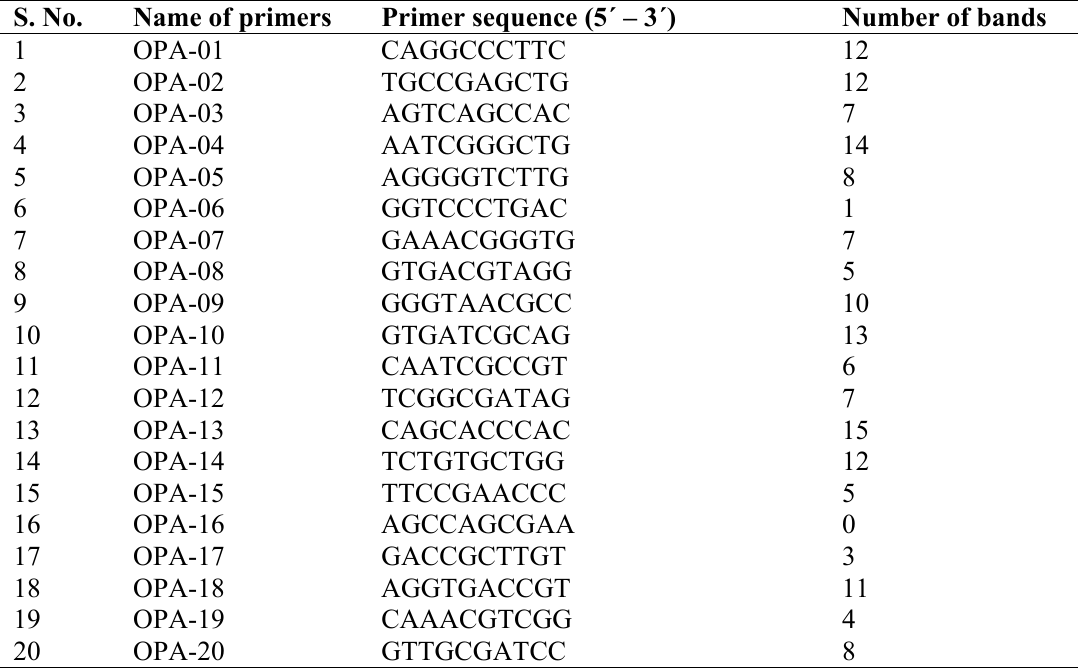
Table 3. List of RAPD primers used to verify the genetic fidelity of micropropagated plantlets of Rauvolfia serpentina .